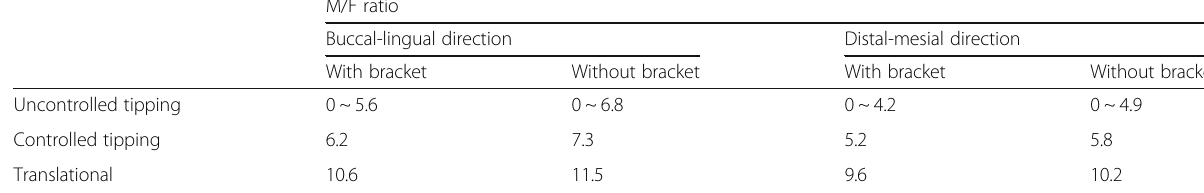
Table 4 The types of canine movements correspond to the M/F ratios